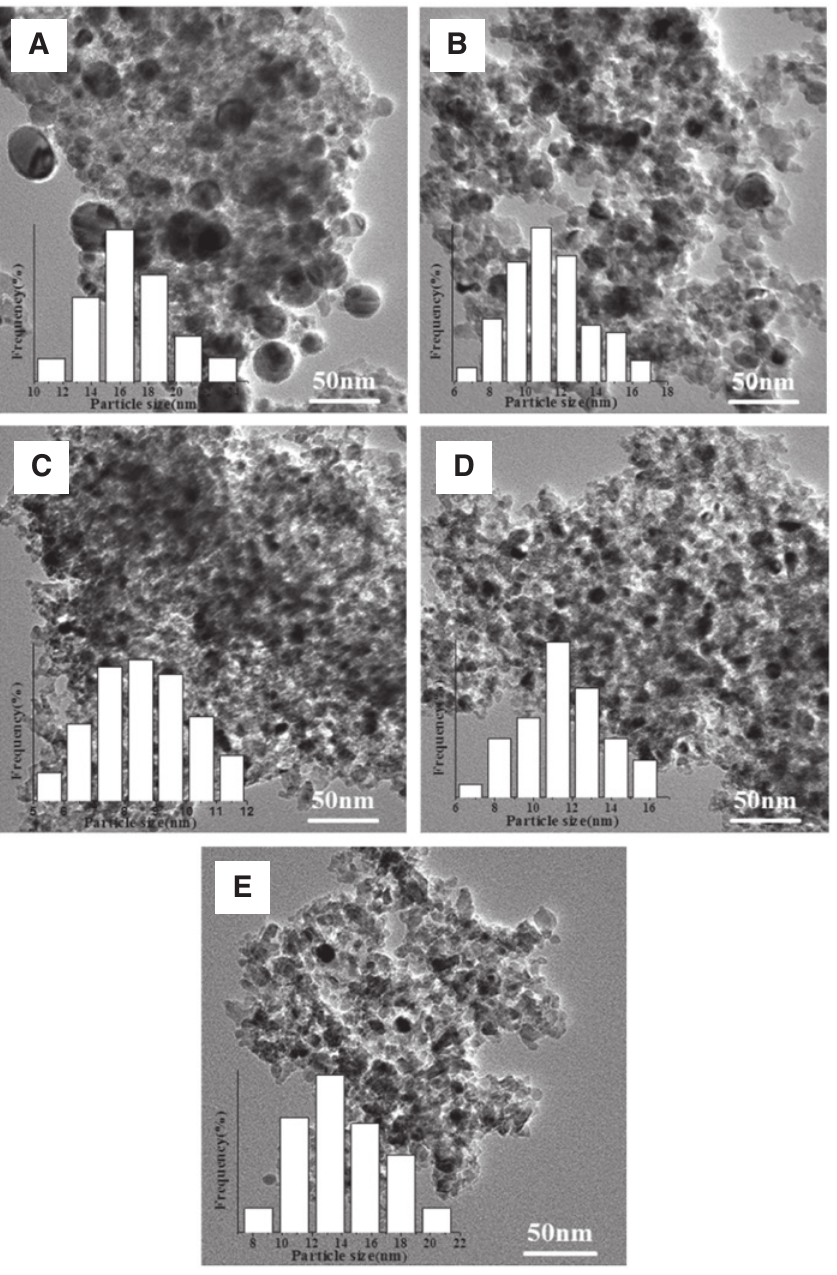
Figure 6: TEM and particle statistical distribution images of the reduced catalysts: (A) Ni-0MA, (B) Ni-0.1MA, (C) Ni-0.25MA, (D) Ni-0.5MA, and (E)